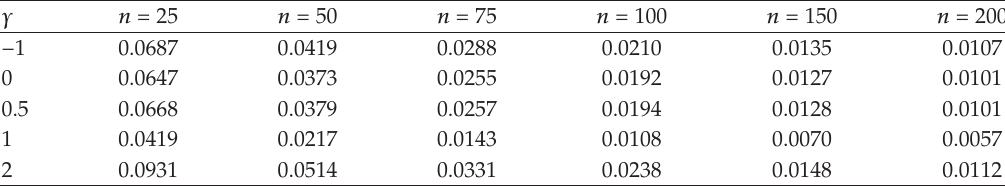
Table 1: MSE of the estimates for the normal distribution, B (cid:6) 500.